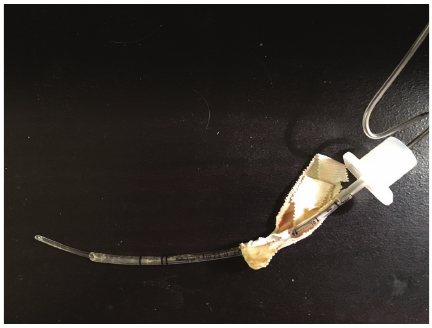
Figure 2: The orientation of the stylet along with the piece of plastic within the endotracheal tube, at the time of